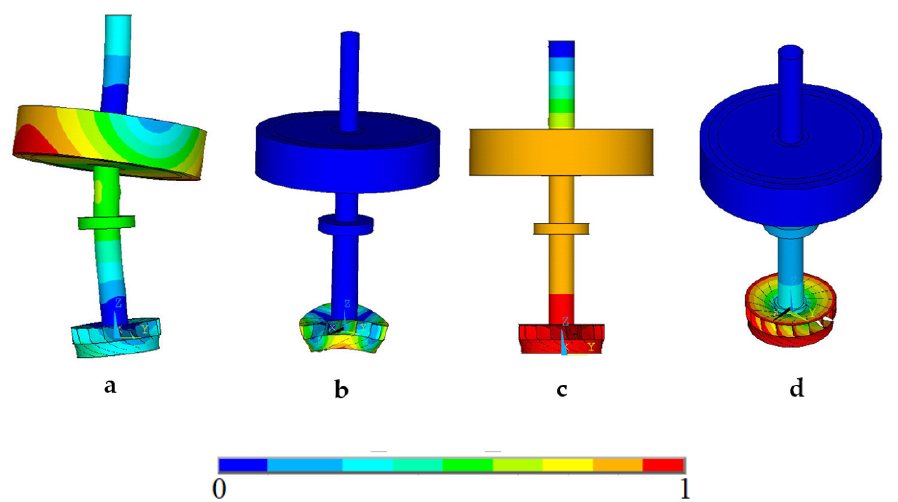
Figure 3. The key types of eigenmodes (the distribution of displacements normalized to 1.0) for the defect-free design: ( a ) type I—bending vibrations with deformation of the unit shaft, f 3 = 10.6 Hz; ( b ) type II—bending vibrations of the runner without deformation of the unit shaft, f 16 = 58.5 Hz; ( c ) type IV—axial (longitudinal) vibrations without radial displacement of the unit shaft, f 8 = 28.1 Hz; ( d ) type III—torsional vibrations without axial and radial displacement, f 7 = 17.6 Hz.